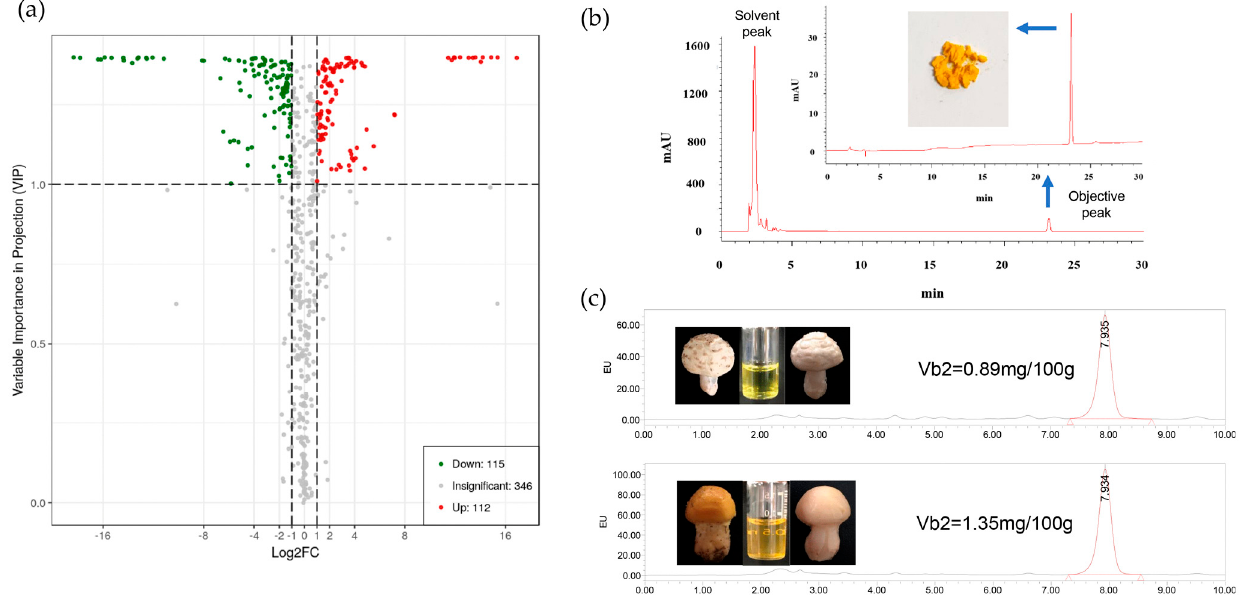
Figure 1. Compound analysis of yellow mushroom. ( a ) Scatter plot of differential accumulation compounds, where red dots represent compounds with high content in yellow mushroom. ( b ) Full scan chromatogram of yellow mushroom at 444 nm after ultrasonic extraction with water. The compound was prepared and freeze-dried for about 23.128 min. ( c ) The white and yellow mushrooms were ultrasonically extracted with water until presentation of the white phenotype, and then the riboflavin content was determined, respectively. Curcumin, a differentially expressed yellow-colored polyphenol, was only found in Table 1. Summary of differently accumulation chemical compounds in yellow and white mush- yellow mushrooms, with the log 2 fold change value reaching 11.43, although its quantitative rooms. value was low. It was found that the content of lysoPC 16:0 in yellow mushrooms was the highest, followed by galactinol and azelaic acid, but they were not yellow compounds. When sorting and screening with the peak area as the estimated content value, it was found that riboflavin held ninth place in terms of content and was dominant in both mushroom species. The riboflavin content of yellow mushroom was high, with the log 2 fold change value reaching